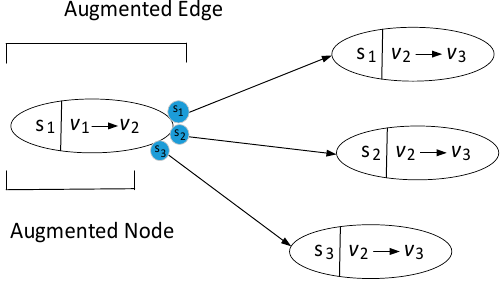
Figure 1. Augmented nodes and edges.